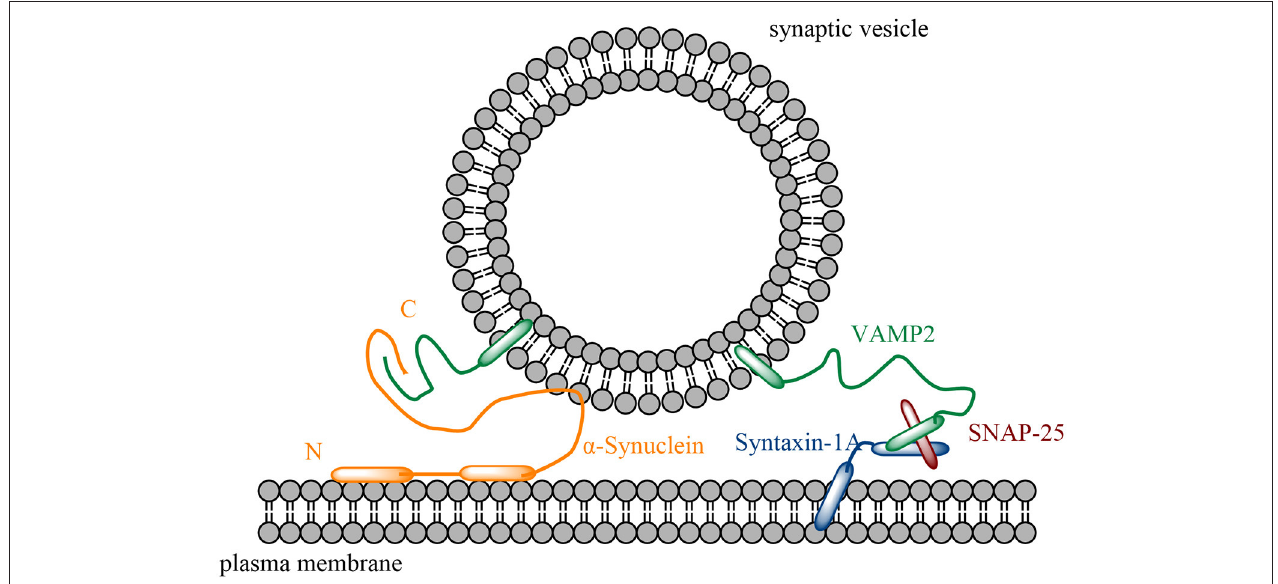
FIGURE 1 | Schematic diagram of α -Syn in SNARE (a complex composed of syntaxin-1A, VAMP2 and SNAP-25)-mediated membrane interaction. α -Syn’s N-terminus forms two helices to interact with the plasma membrane, while α -Syn interacts with VAMP2 at the C-terminus.